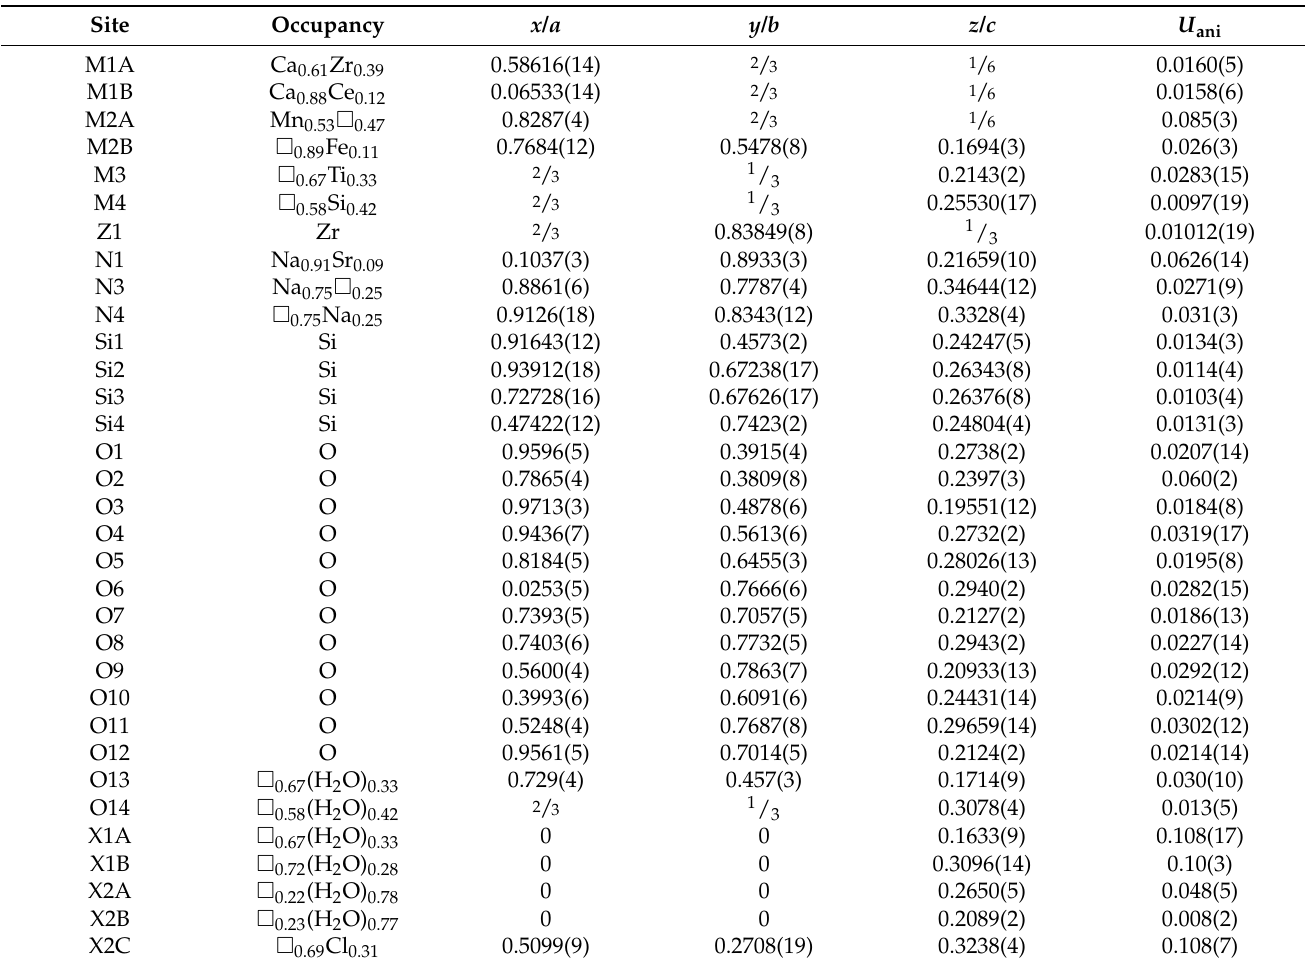
Table 4. Atomic coordinates, occupancies and equivalent isotropic displacement parameters LV-117/226 EGM